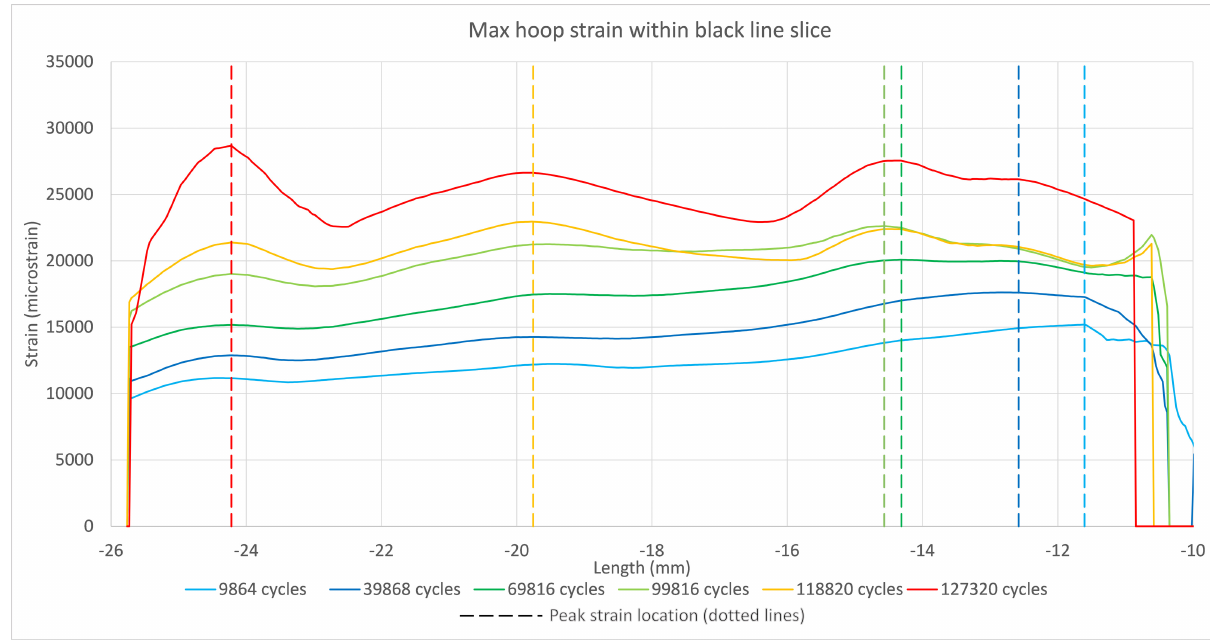
Figure 10: Maximum hoop strain over the black line slice with location of peak strain over the line slice thickness plotted. As can be seen there is extensive redistribution